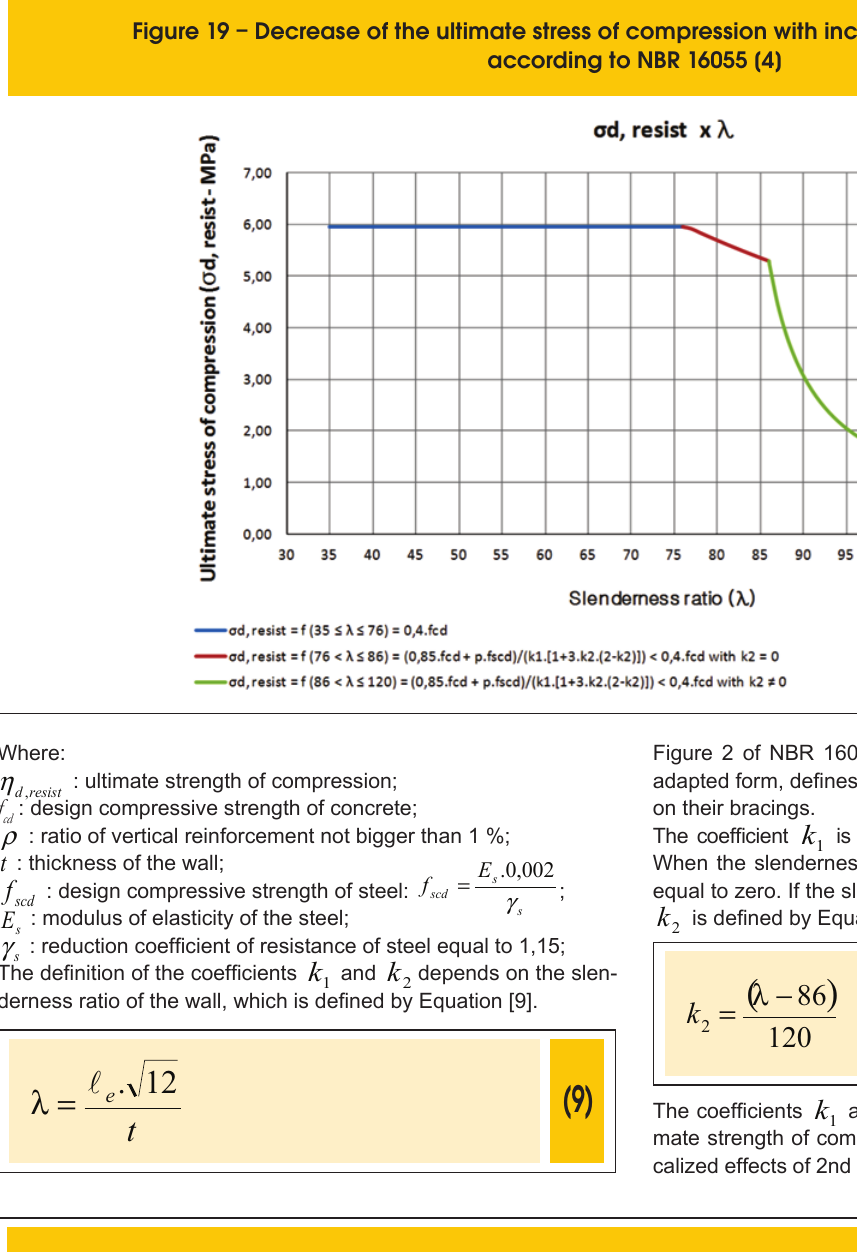
Table 8 – Calculation of the ultimate strength of compression as NBR 16055